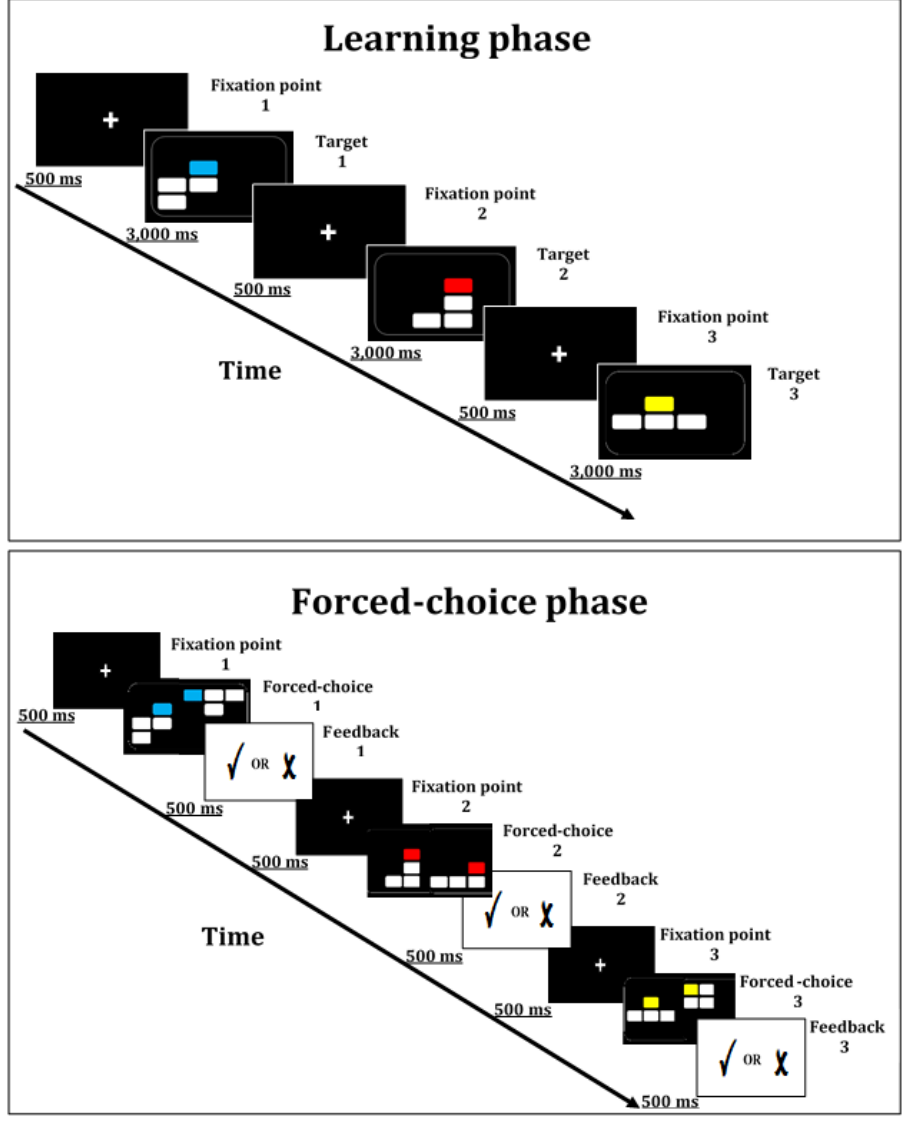
Figure 1. Examples of the learning phase ( top ) and forced-choice recognition phase ( bottom ) of the MPMT.